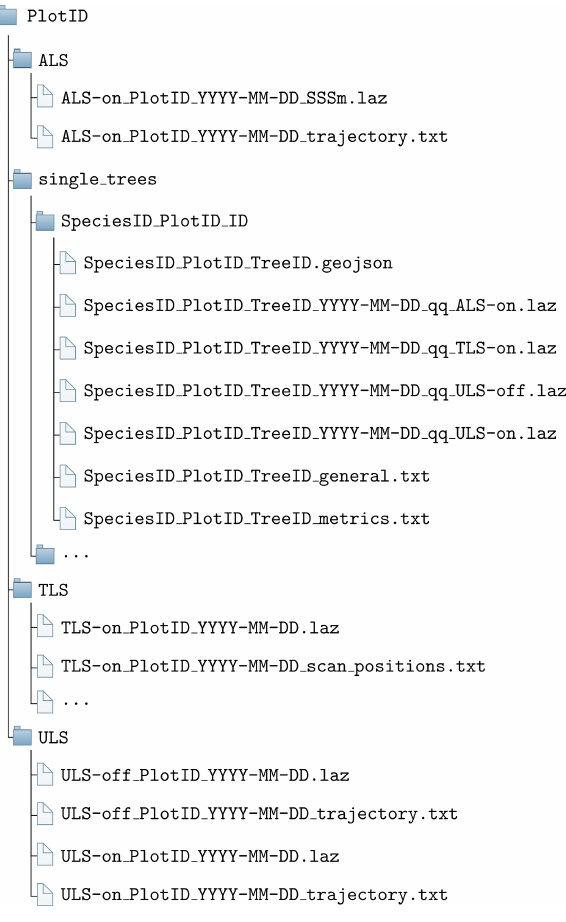
Figure 7. Folder structure for a single forest plot. PlotID is the ID of the forest plot, e.g., BR01; SpeciesID is the ID of the tree species, e.g., AcePse; see Table 4; TreeID is the unique (in combination with PlotID and SpeciesID) identifier for the tree; YYYY-MM-DD is the day of acquisition; qq is the quality indicator, e.g., q2; on/off is the canopy condition; and SSSm is the side length of the ALS forest plot in meters, e.g., 300m. The ALS folder contains only one point cloud per plot. Multiple point clouds may be within the ULS folder due to different acquisition times and in the TLS folder due to differ- ent acquisition times and locations (in case of several acquisitions in the same plot on the same day, a suffix is added to distinguish the acquisitions, i.e., “_A”, “_B”, etc.). The single_trees folder always contains several subfolders, one for each